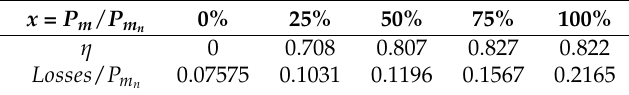
Table 3. Manufacturer data with the no-load loss